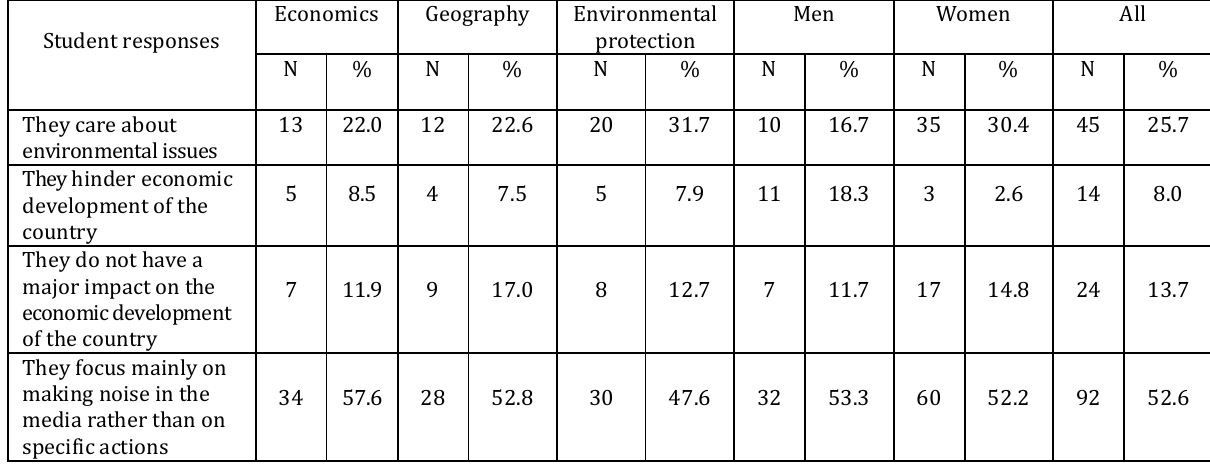
Table 10. The responses of the students to the question 10. "What is your opinion about the activities of Environmental Organizations?"